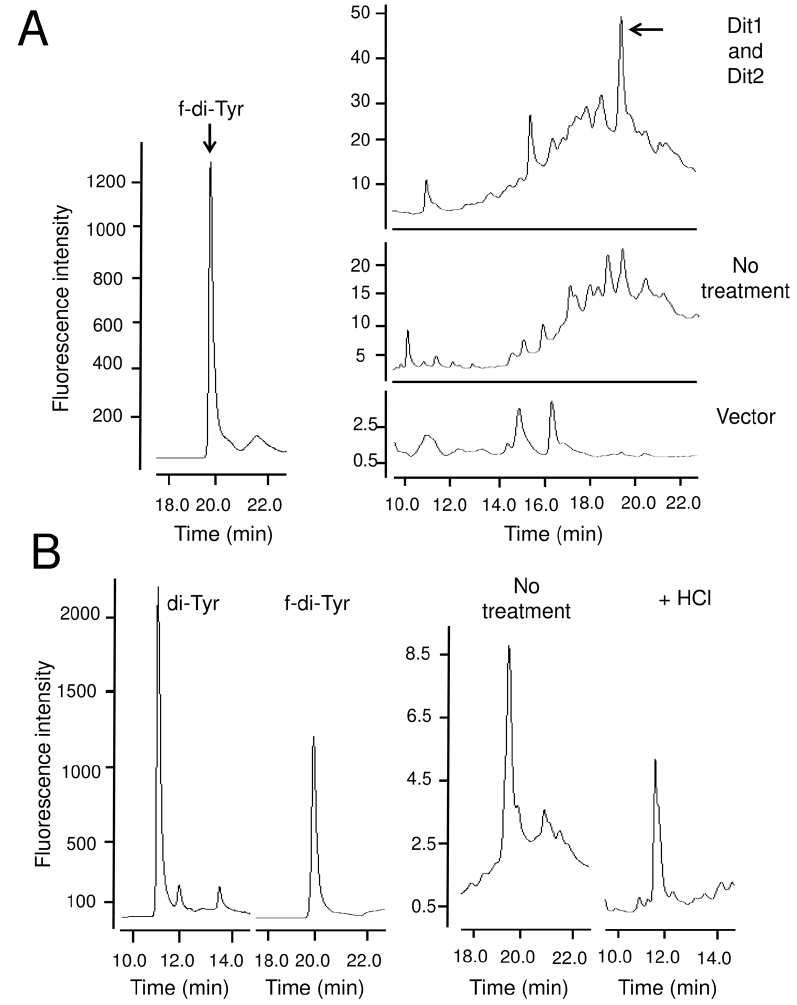
Figure 7. Bisformyl dityrosine detection in vegetative cells coexpressing Dit1 and Dit2. ( A ) The lysate of vegetative cells harboring pRS424GAL1-DIT1-GFP and pRS426GAL1-DIT2-FlAG (Dit1 and Dit2), or pRS424GAL1 and pRS426GAL1 (Vector) were treated with or without (no treatment) trisodium citrate and subjected to HPLC analysis. Formyl dityrosine (f-di-Tyr) is shown as a control. Arrows indicate formyl dityrosine peaks. ( B ) The formyl dityrosine peak detected in the lysates of vegetative cells harboring pRS424GAL1-DIT1-GFP and pRS426GAL1-DIT2-FlAG was collected, hydrolyzed with 6 N HCl and subjected to HPLC analysis. Dityrosine (di-Tyr) and formyl dityrosine (f-di-Tyr) are shown as